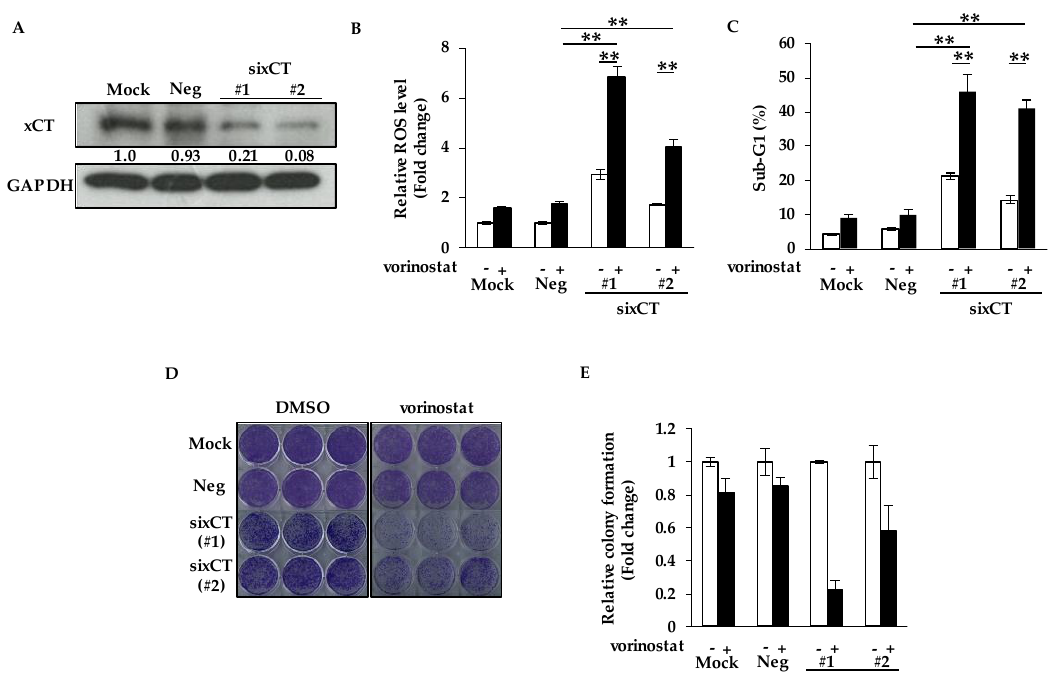
Figure 2. Genetic ablation of xCT increases sensitivity to vorinostat with reactive oxygen species (ROS) accumulation. ( A ) The knockdown efficacies of sixCT were validated by Western blotting in MDA-MB-231 cells. The gray value of bands was assessed by imageJ. GAPDH was used as a loading control. ( B ) Flow cytometry analysis of ROS levels in cells treated with vorinostat after transfection of sixCT or negative control siRNA (siNeg). MDA-MB-231 cells were treated with 1.6 μM vorinostat for 48 h following the treatment of each siRNA. The amount of ROS in cells was detected by CM-H2DCFDA using a flow cytometer. The data obtained with DMSO control in siNeg were taken as 1. Columns, means ( n = 3); bars, SD. ** p < 0.01. ( C ) Flow cytometry analysis of cell death after